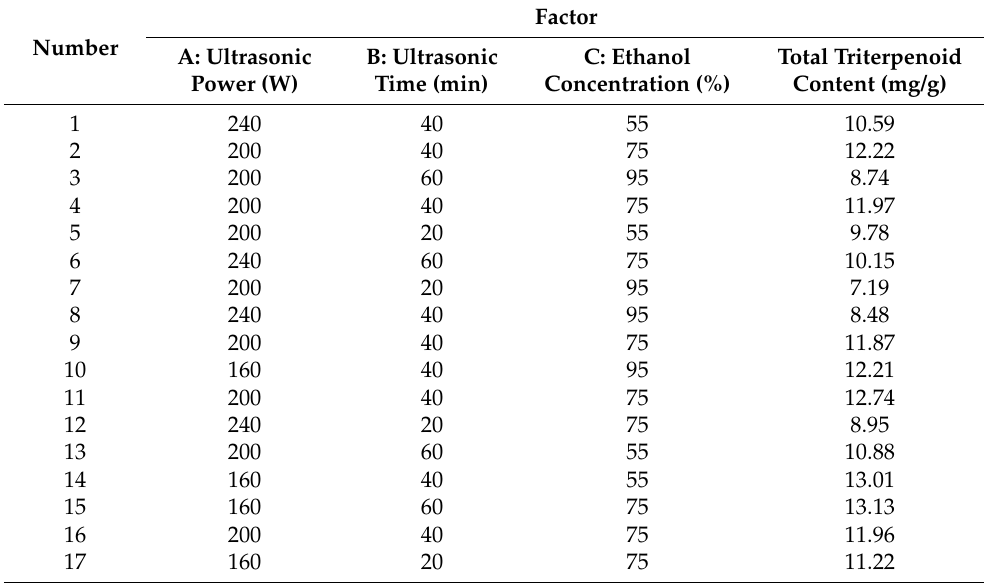
Table 1. Experimental results of response surface methodology (Loquat Peel).